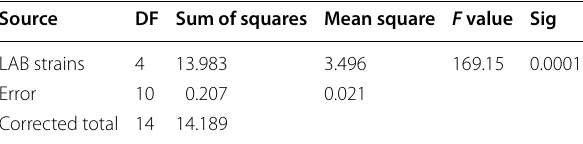
Table 2 ANOVA table describes the effect of different types of LAB strain on encapsulation efficiency of LAB microcapsules